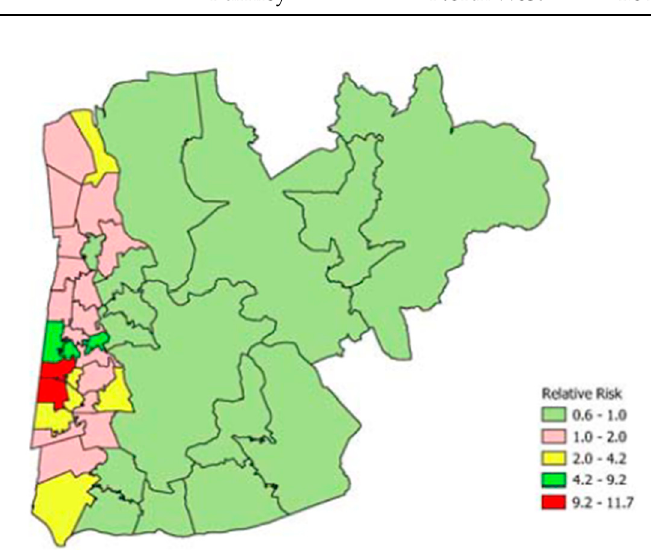
Figure 4. Drug-related death risk by MSOA (Blackpool, Fylde, Wyre). Table 8. MSOAs with Highest Suicide Relative Risk, With Socio-Economic and Locational Details.